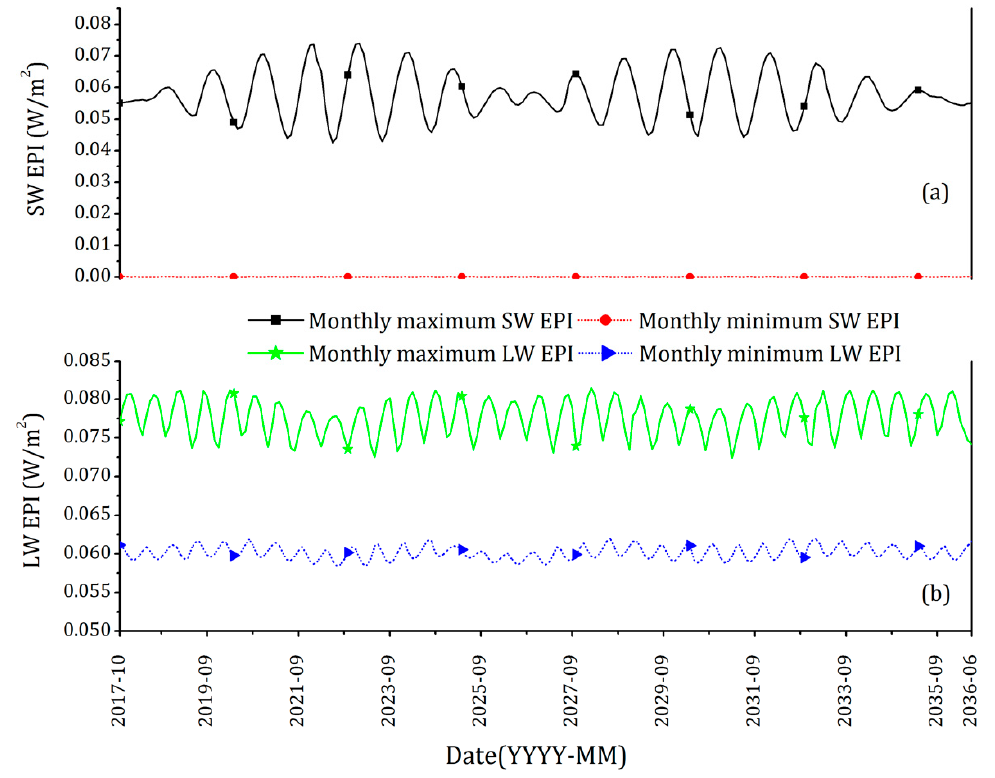
Figure 10. ( a ) Monthly maximum and minimum SW entrance pupil irradiances (EPIs); ( b ) monthly maximum and minimum LW EPIs of a hypothetical MERO sensor located at the Apollo 15 landing site over a major lunar standstill cycle from October 2017 to June 2036 with an assumption of temporally constant Earth TOA SW and LW fluxes.